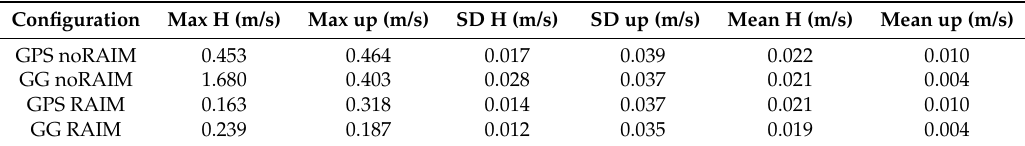
Table 8. Velocity error statistics considering only reliable epochs.